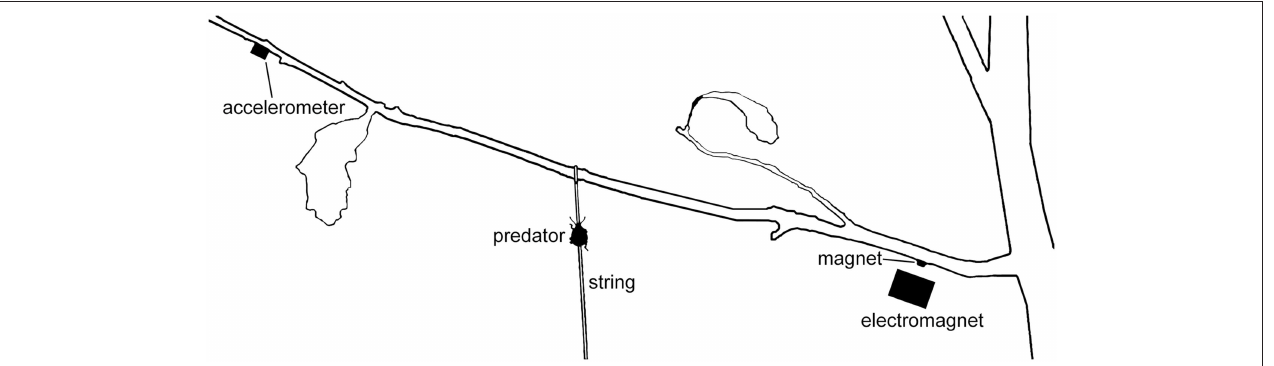
FIGURE 2 | Playback setup for Experiments 4 and 5. Predatory stinkbugs were introduced to string and allowed to walk up to the branch of a potted Q. alba sapling. Vibrational stimuli were imparted using an electromagnet driving a magnet attached to the branch at the typical resting location of a female oak treehopper and monitored using an